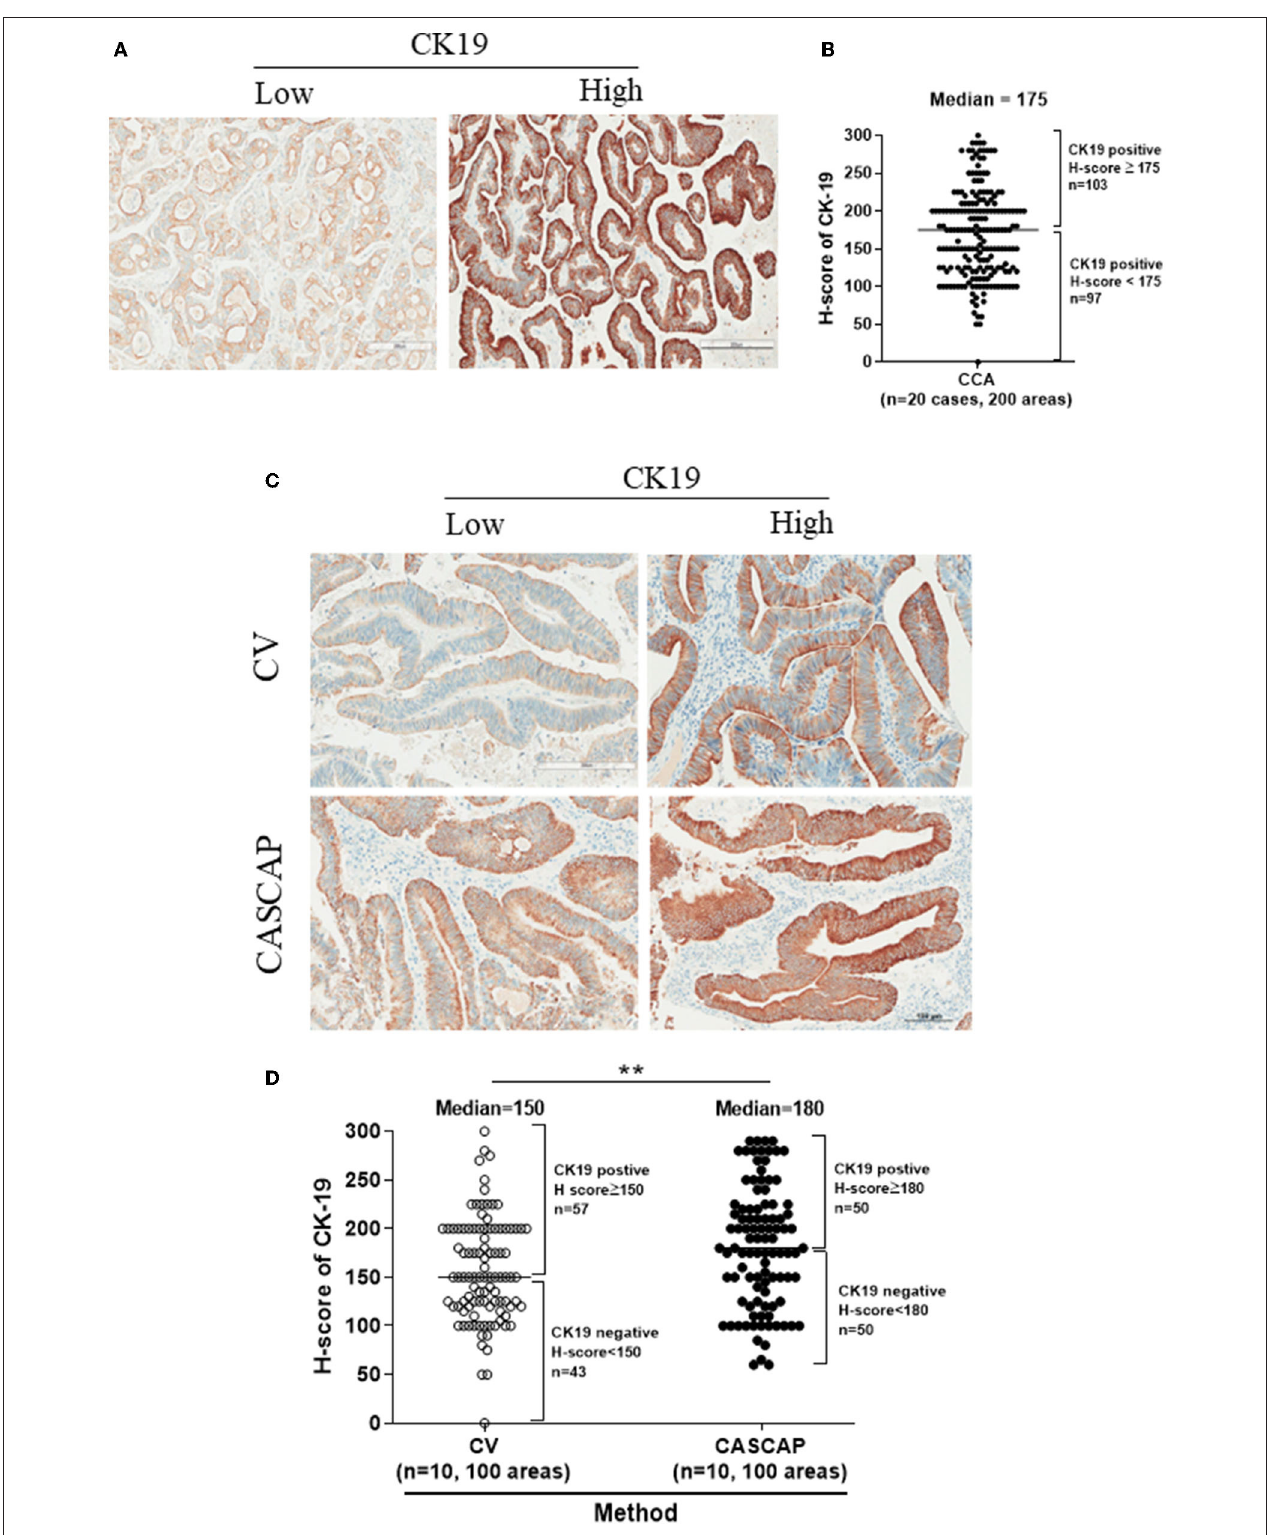
FIGURE 4 | The expression levels of CK19 in total cases were categorized by the median of H-score (175) including low (H-score < 175) and high CK19 (H-score ≥ 175) (A,B). The individual category of CK19 levels in each method (C,D) were present as mean ± SEM. ** p < 0.01.